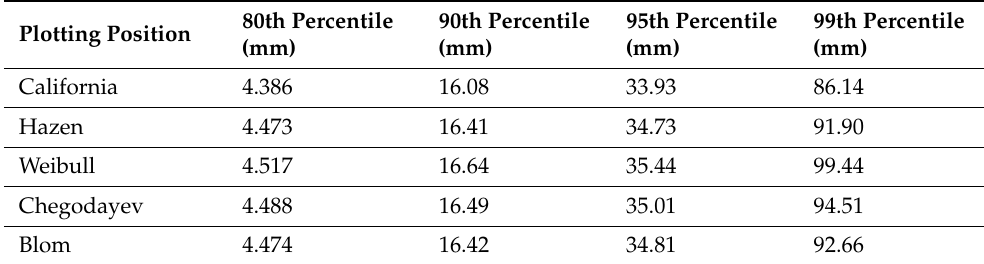
Table 3. Corresponding rainfall amount for each plotting